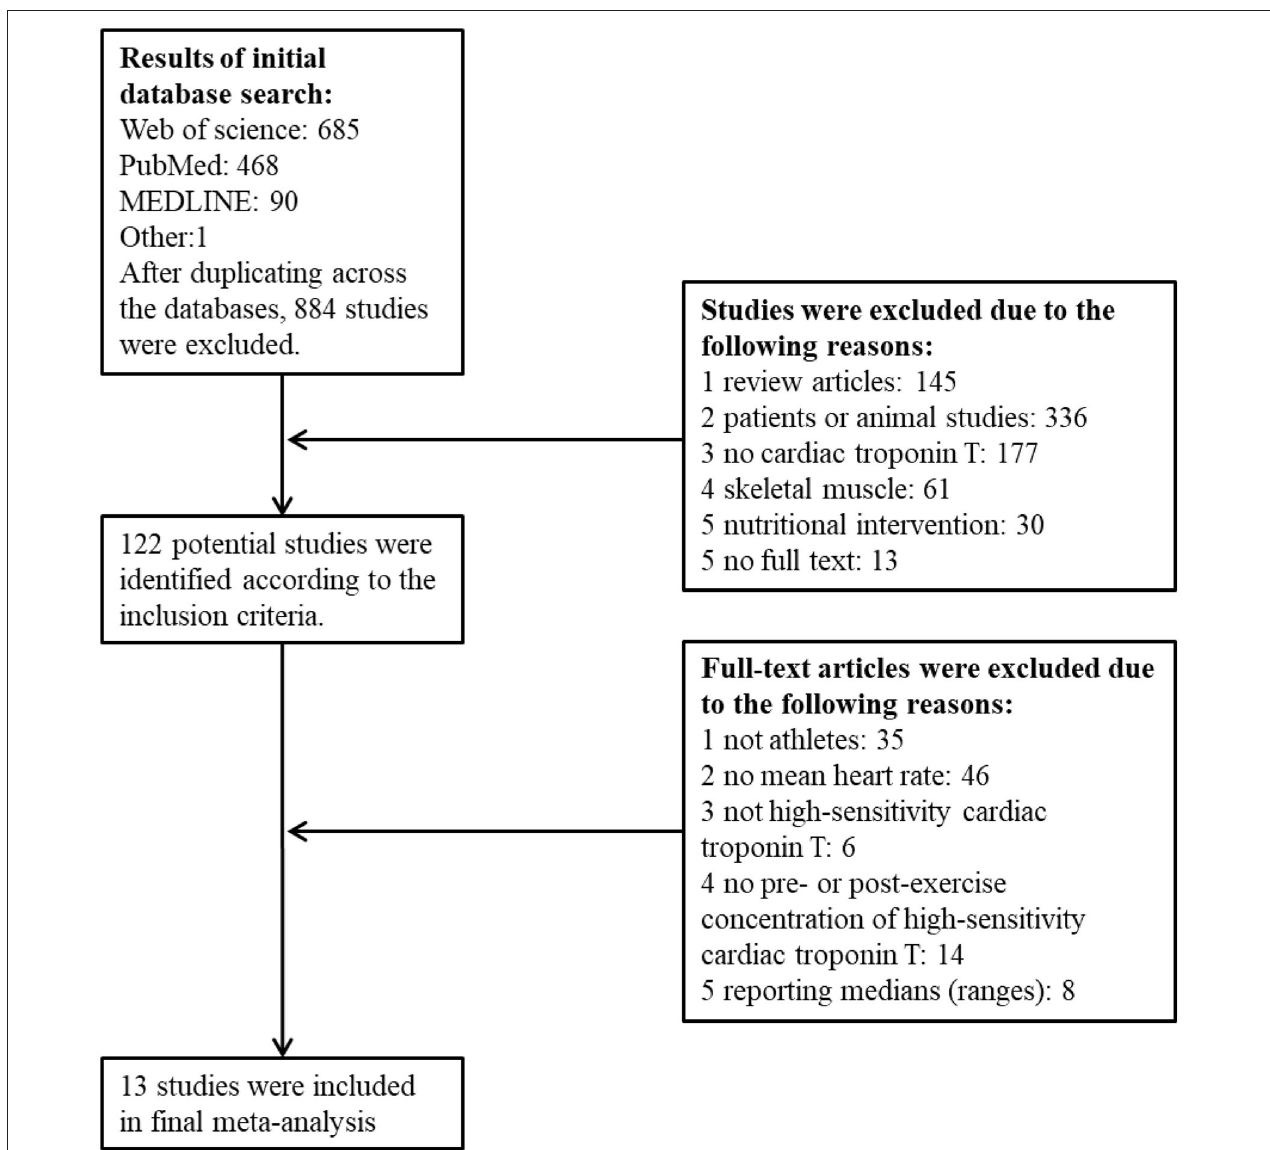
FIGURE 1 | PRISMA flow chart outlining literature search, inclusion and exclusion of studies.